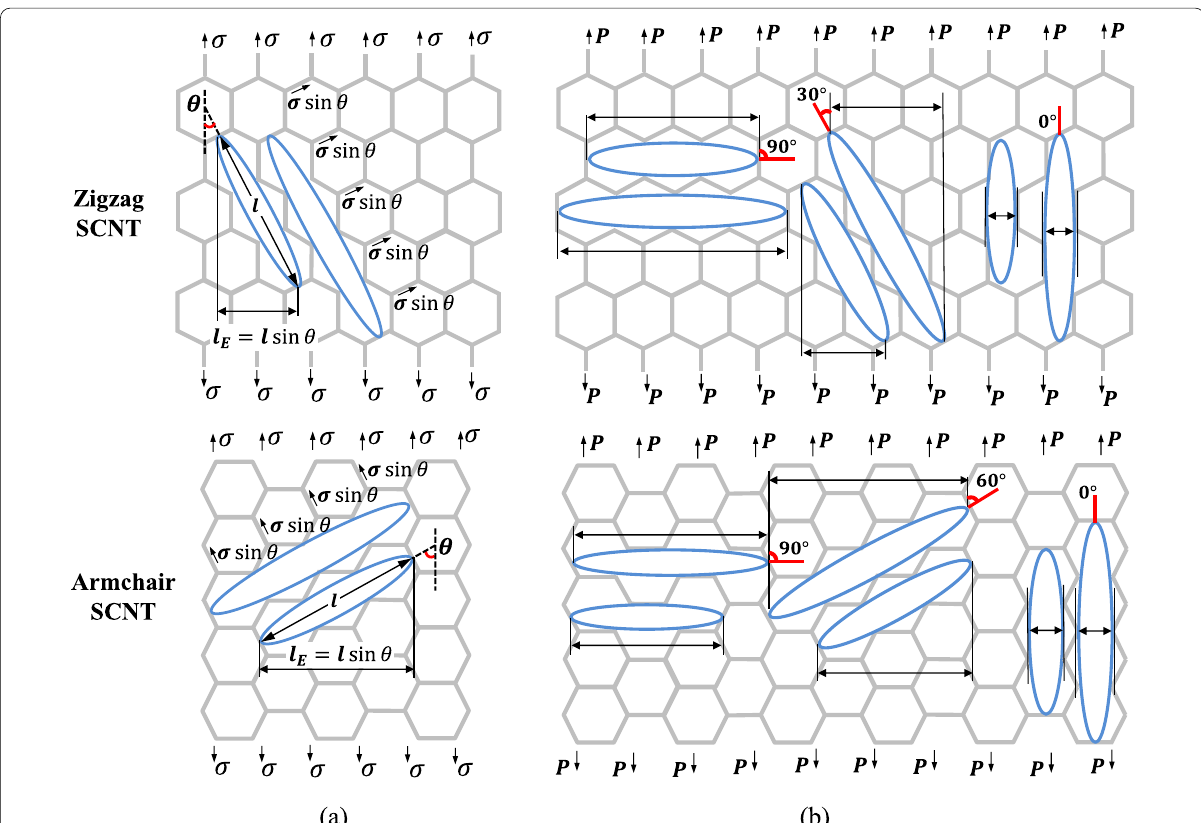
Fig. 9 Illustration and comparison of the effective crack length of defective SCNTs. a Effective crack lengths of the defects in the armchair and zigzag SCNTs; b Effective length of the cracks formed by different oriented defects in the armchair and zigzag